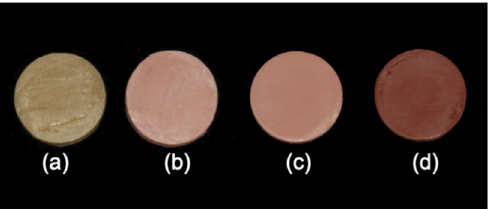
Figure 8. 3D printed PEEK with gingiva-like colors. ( a ) pure PEEK for contrast; ( b ) G1 (20% TiO 2 /1% Fe 2 O 3 /PEEK); ( c ) G2 (10% TiO 2 /1% Fe 2 O 3 /PEEK); ( d ) G3 (1% Fe 2 O 3 /PEEK).